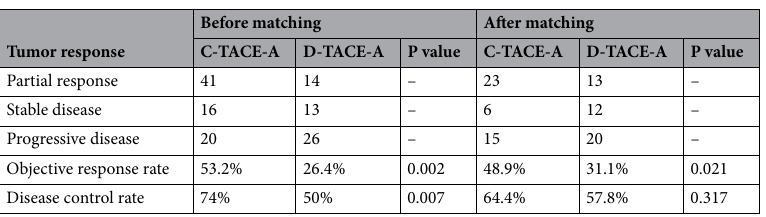
Table 2. Analysis for tumor response at 3 months after patients receiving TACE-A.